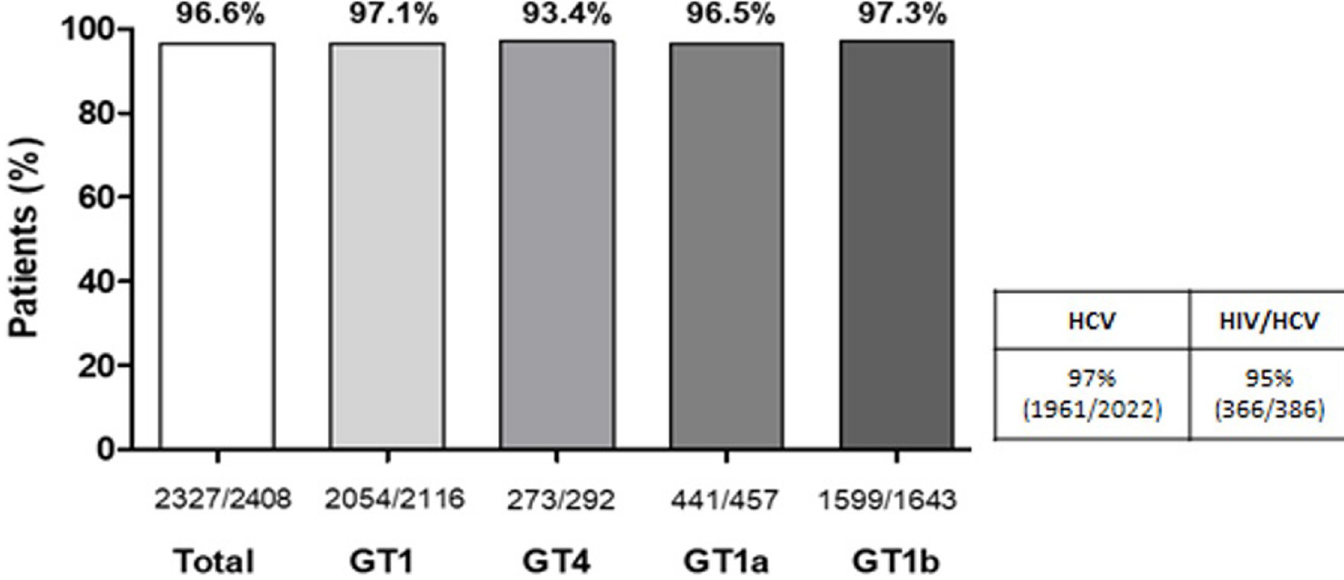
Fig 1. SVR12 according to genotype (ITT analysis). Abbreviations: GT, genotype; SVR12, sustained virologic response at 12 weeks; ITT, intention-to-treat. Abbreviations: GT, genotype; HCV, hepatitis C virus; HIV, human immunodeficiency virus.